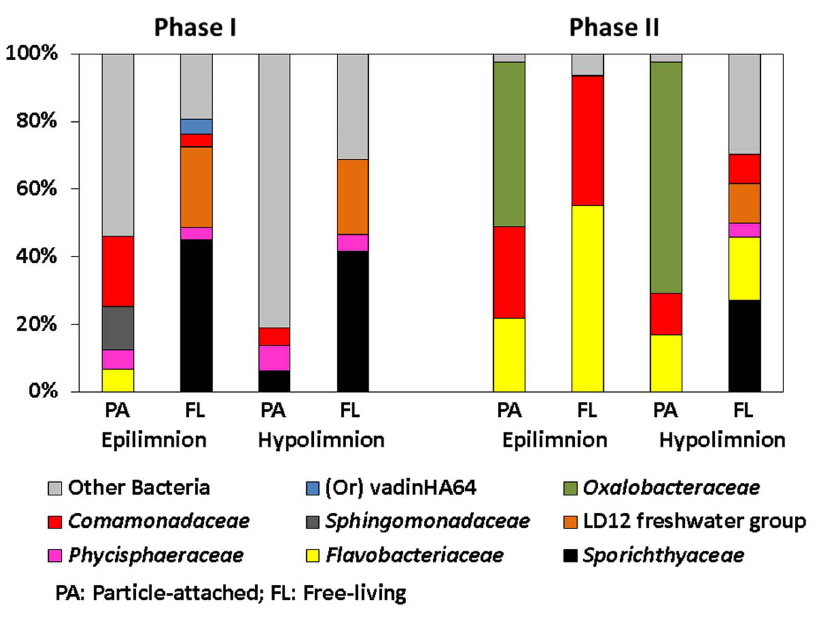
Figure 6. Sequence frequencies of major particle-attached (PA) and free-living (FL) bacterial families comprising to . 5% of total sequences in at least one sample in the epilimnion and hypolimnion of Lake Stechlin during Phase I and Phase II of the under-ice